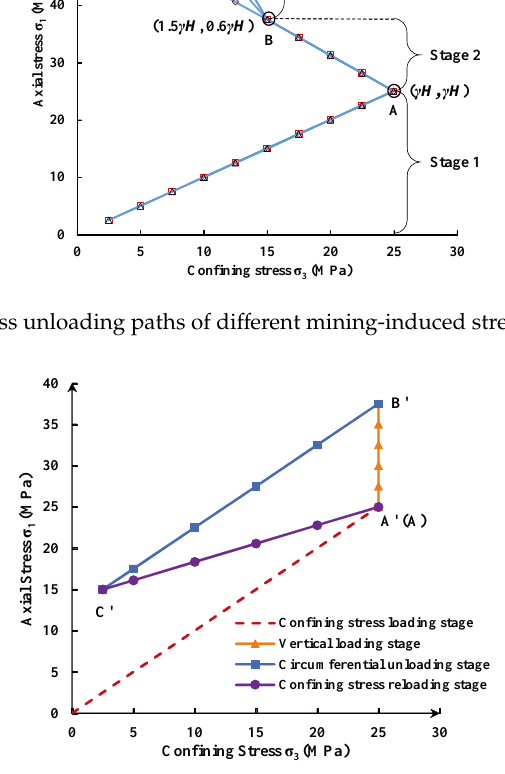
Figure 3. The simulation stress path of the premining unloading process in PCM [22].